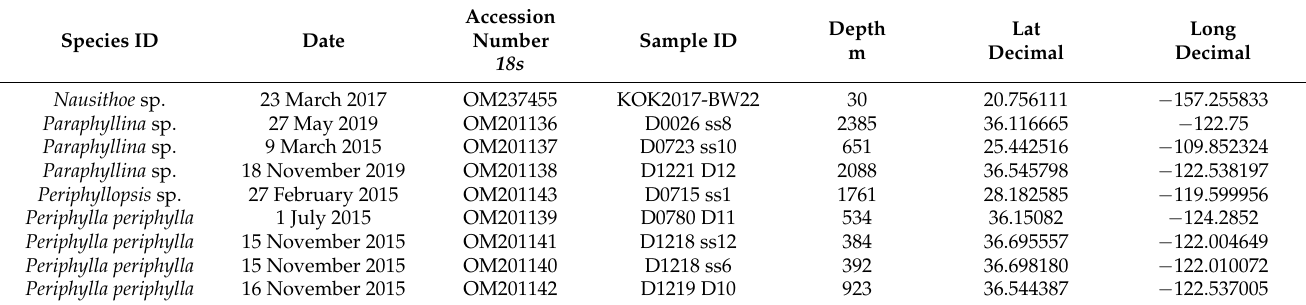
Table 5. Coronate genera sequenced for rooting in the 18S rDNA molecular tree.